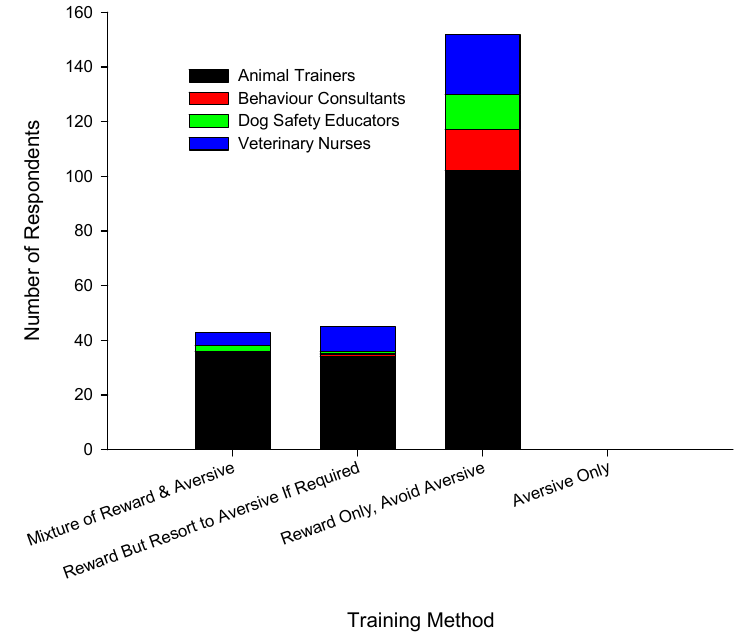
Figure 1. Number of respondents that reported using different training methods: A mixture of reward and aversive methods, reward but would resort to aversive methods if required, reward only and avoided aversive methods and aversive only.